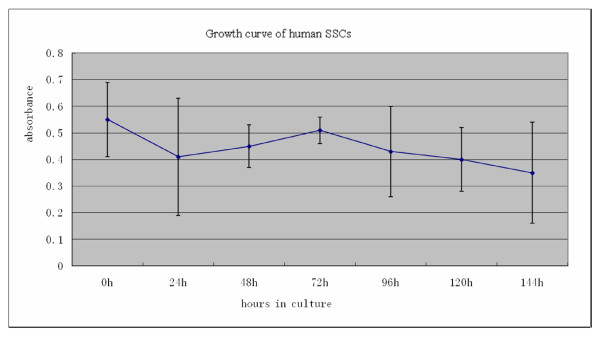
Statistical analysis of MTT values (72 h vs. 24 h, 48 h and 96 h, P < 0.01) was performed. The A is absorption value at a wavelength of 570 nm. Human SSCs in vitro has a value-added short period, but then gradually reduced the number of cells. The results shown are from three trials.